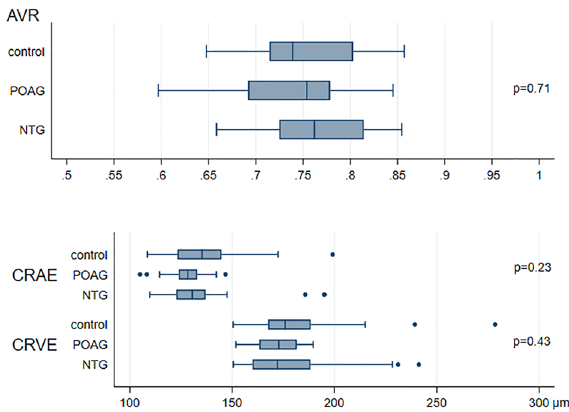
Figure 2. Bar graph of AVR, CRAE and CRVE values in the NTG, POAG and control groups. Data are expressed as median (interquartile range, 25–75th percentiles). AVR arteriole-to-venule ratio, CRAE central